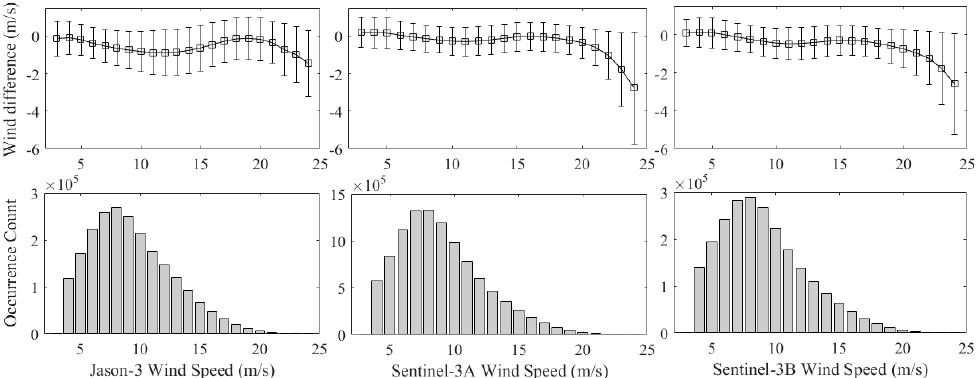
Figure 8. Dependence of statistical parameters of WS differences between the Sentinel-3A/3B and Jason-3 altimeters and ASCAT on altimeter-derived WS.